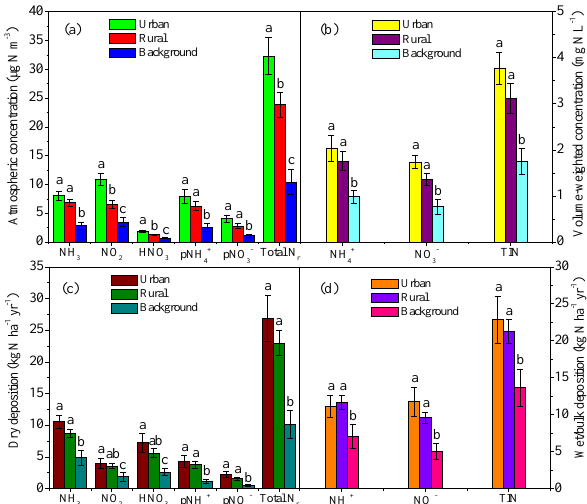
Figure 4. Annual mean concentrations and deposition fluxes of N r compounds at different land use types across China: concentrations in air (a) ; volume-weighted concentrations in precipitation (b) ; dry N deposition fluxes (c) ; wet/bulk N deposition fluxes (d) . The num- ber of sites with the same land use type can be found in Table S1 in the Supplement. The error bars are the standard errors of means.